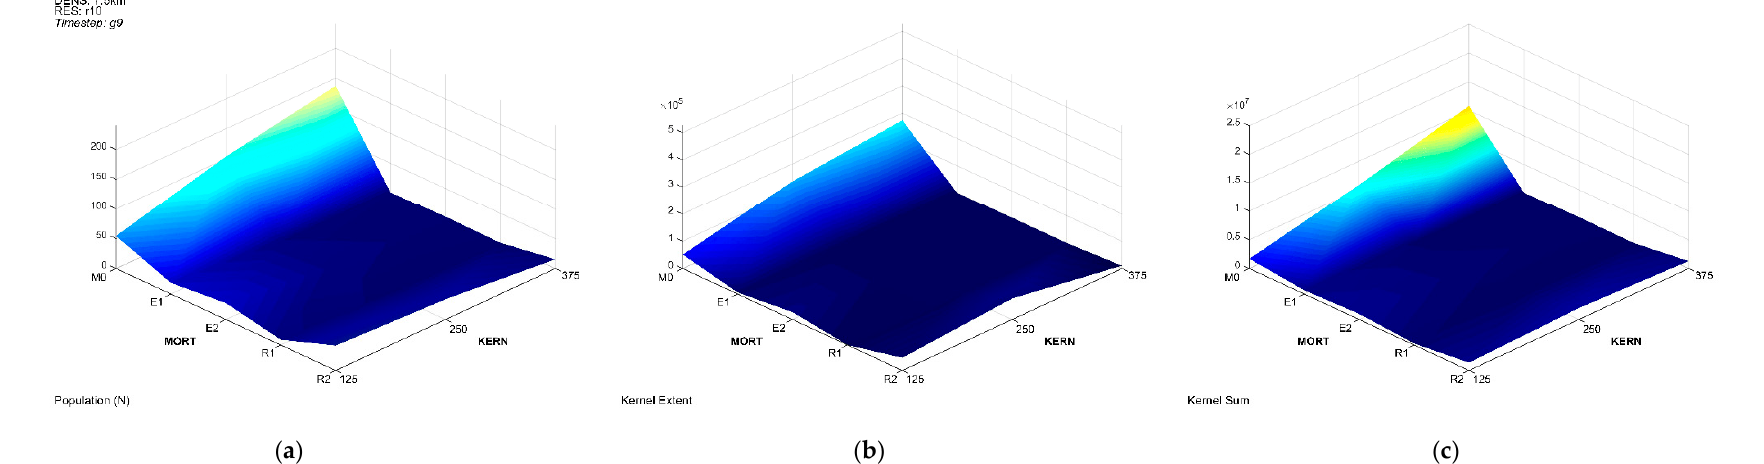
Figure 4. Surface plots showing variation in predicted ( a ) population size ( N ), ( b ) kernel extent, and ( c ) sum of kernel value for the 15 combinations of dispersal ability (KERN—3 levels) and mortality risk (MORT—5 levels) for resistance transformation 1.0 (RES—r10) and maximum density 1/7.5 km 2 (DENS—7.5 km) at timestep 9. The figure shows a strong interaction between dispersal ability and mortality risk, with the predicted values of all three variables remaining low for all scenarios involving elevated mortality risk, across all dispersal abilities, while all three variables increase linearly with dispersal ability when there is no differential mortality risk across the landscape. Animations of these and other plots can be viewed in Supplementary Materials 3, Tables S7–S12.